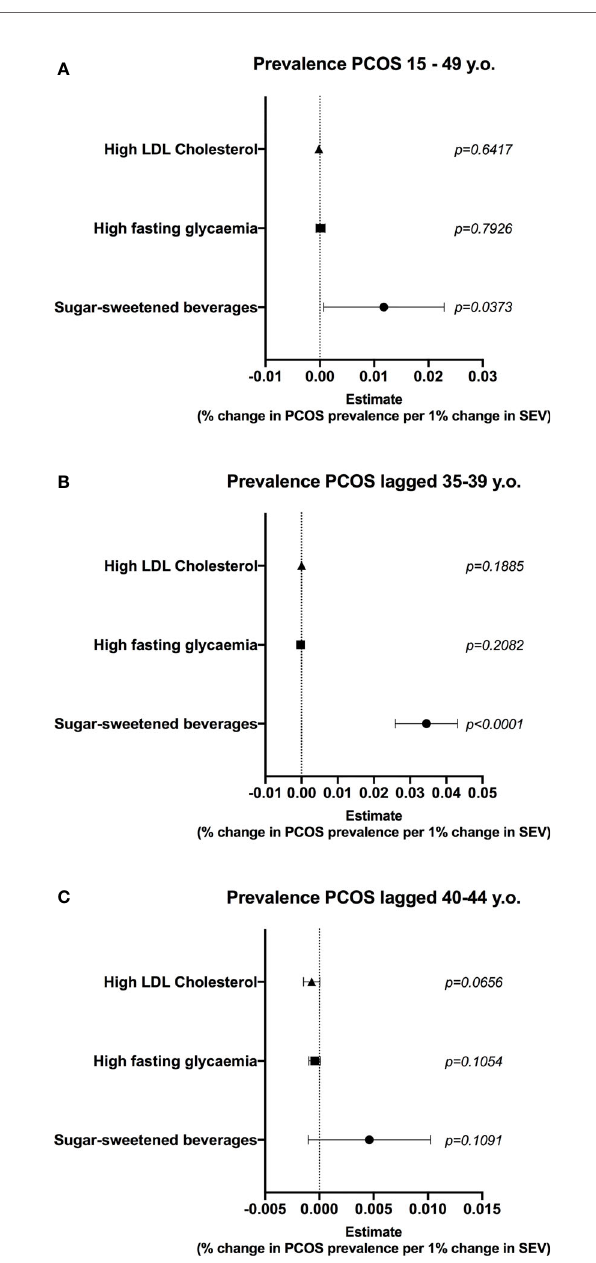
FIGURE 6 | Consumption of diet high in sugar-sweetened beverages is correlated with prevalence of PCOS in women at reproductive age. A multiple linear regression model (459 state-year observations) was used to test the correlation between diet high in sugar-sweetened beverages and prevalence of polycystic ovary syndrome (PCOS). State and year fi xed effects were included in the model. Gross domestic product (GDP) per capita was used to control for income. (A) Correlation between summary exposure value (SEV) of risk factors and prevalence of PCOS in women at reproductive age. (B) Correlation between SEV of risk factors and prevalence of PCOS 10 years later, in women aged 35-39. (C) Correlation between SEV of risk factors and prevalence of PCOS 10 years later, in women aged 40-45. Graphs express mean ± 95% con fi dence interval and p is shown for each